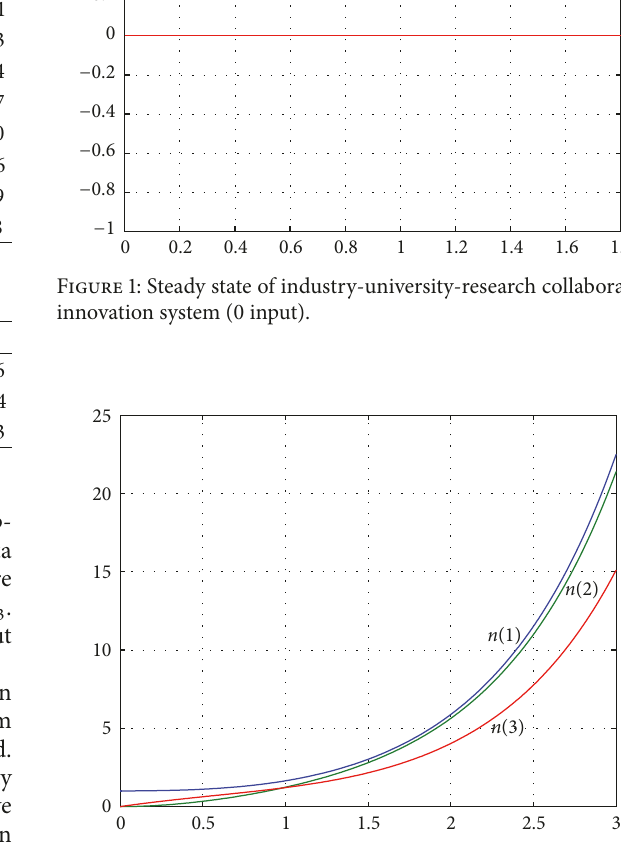
Figure 2: Evolution curve of variables when the initial state set as [1, 0,0]